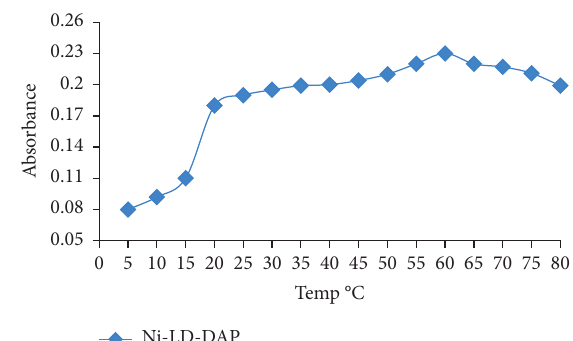
Figure 5: Effect of temperature for the maximum absorbance signal on the determination of LD.